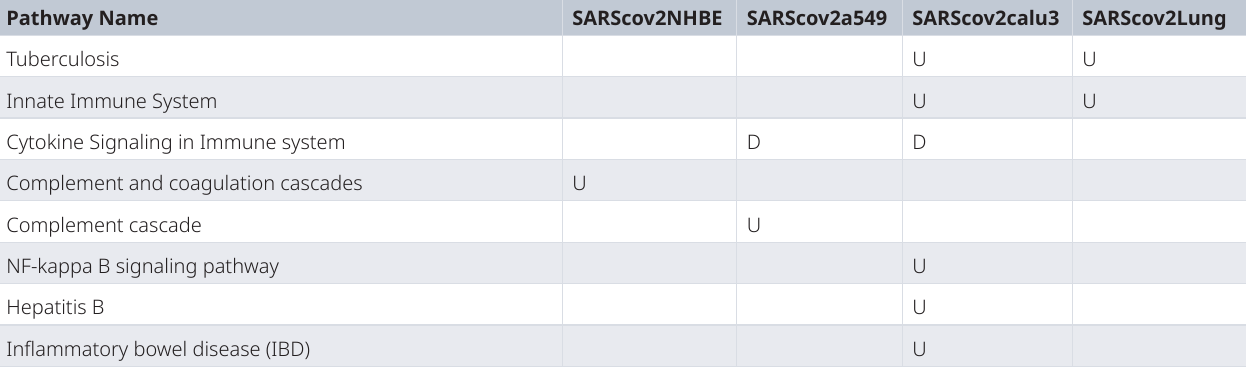
Table 1. Intracellular signaling pathways predicted to be significantly affected during infection with SARS-CoV-2